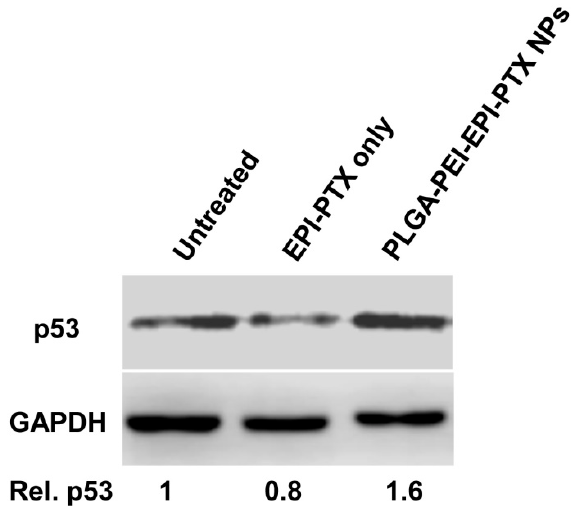
Figure 10. Western blot analysis study: A549 cells treated with EPI-PTX only and PLGA-PEI-EPI-PTX NPs, showing overexpression of p53 relative to control, and normalized protein expression. GAPDH was used as a loading control. The experiments were conducted in three replicates.